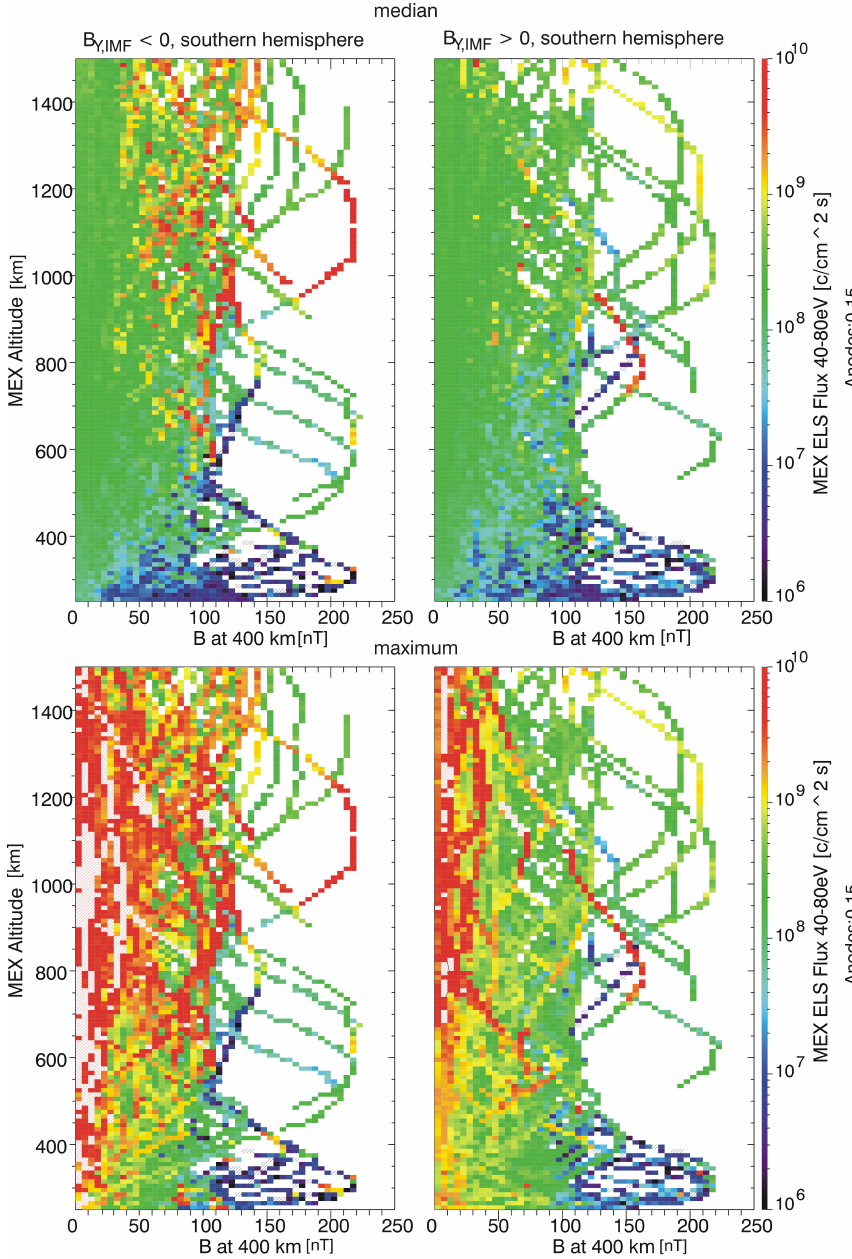
Fig. 6. Total median (top panels) and maximum (bottom panels) fluxes of electrons (40eV <E e < 80eV) on the nightside of the Southern Hemisphere as a function of the crustal field strength and altitude for B y IMF > 0 and B y IMF <